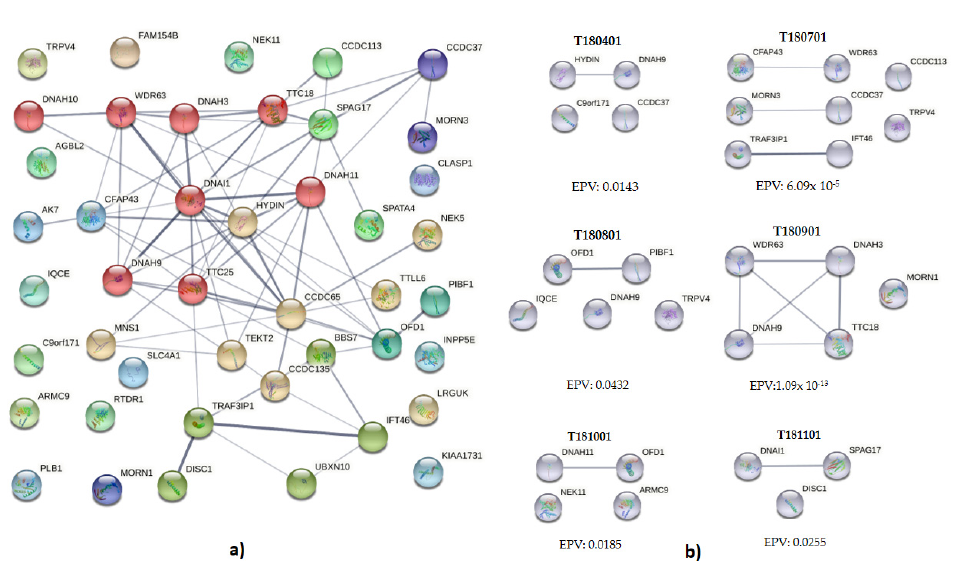
Figure 2. Genetic abnormality aggregation in patients with transposition of the great arteries. Global interaction of anomalies found in patients ( a ) The shared colors represent the clustering according to the Markov algorithm. Ciliary genetic anomalies are observed in genes involved in diverse processes such as ciliogenesis, ciliary trafficking, and the function of motile cilia. Individual patient aggregation of missense, nonsense, frameshift, and splicing deleterious variants is observed ( b ). In both, the line thickness indicates the strength of data support and the confidence of interactions; the thinnest line represents low confidence (0.150), next, medium confidence (0.400); then, high confidence (0.700), and, finally, the thickest line is the highest value (0.900). EPV. Enrichment p -value. We next examined deleterious variants of TGA genes using an individual in silico functional interaction analysis. In 6 out of 11 analyzed probands (54.5%), clustering and